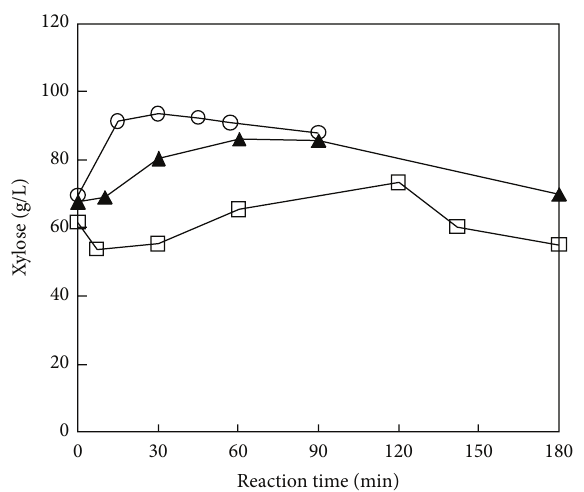
Figure 5: Time courses of xylose concentration in second step EFB hydrolysis at different acid concentrations. ◻ : 2% (w/v) H 2 SO 4 and 0.8% (w/v) H 3 PO 4 ; 󳵳 : 2.5% (w/v) H 2 SO 4 and 1% (w/v) H 3 PO 4 ; I : 3% (w/v) H 2 SO 4 and 1.2% (w/v) H 3 PO 4 . Other conditions: liquid to solid ratio 3 mL/g, 130 ∘